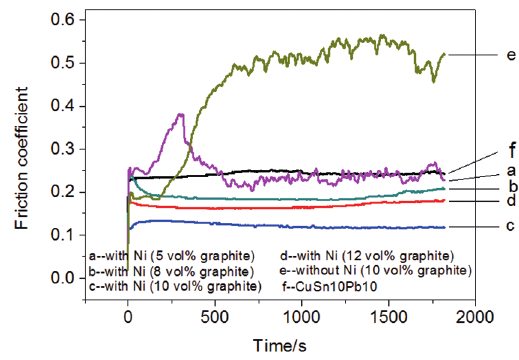
Figure 5: Friction coefficient curves of Ni containing graphite-CuSn10 composite layers with different graphite content: (a) 5 vol%, (b) 8 vol%, (c) 10 vol%, (d) 12 vol%; (e) friction coefficient curve of no Ni containing graphite-CuSn10 composite layers with 10 vol% graphite, (f) friction coefficient curve of CuSn10Pb10 alloy layers